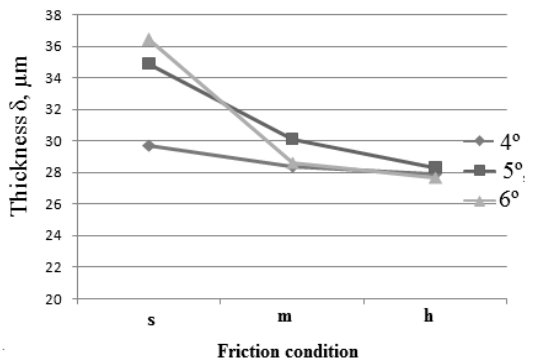
Figure 11. E ff ect of the friction conditions on the thickness of the fine grain layer at di ff erent Figure 11. Effect of the friction conditions on the thickness of the fine grain layer at different die die semi-angles.